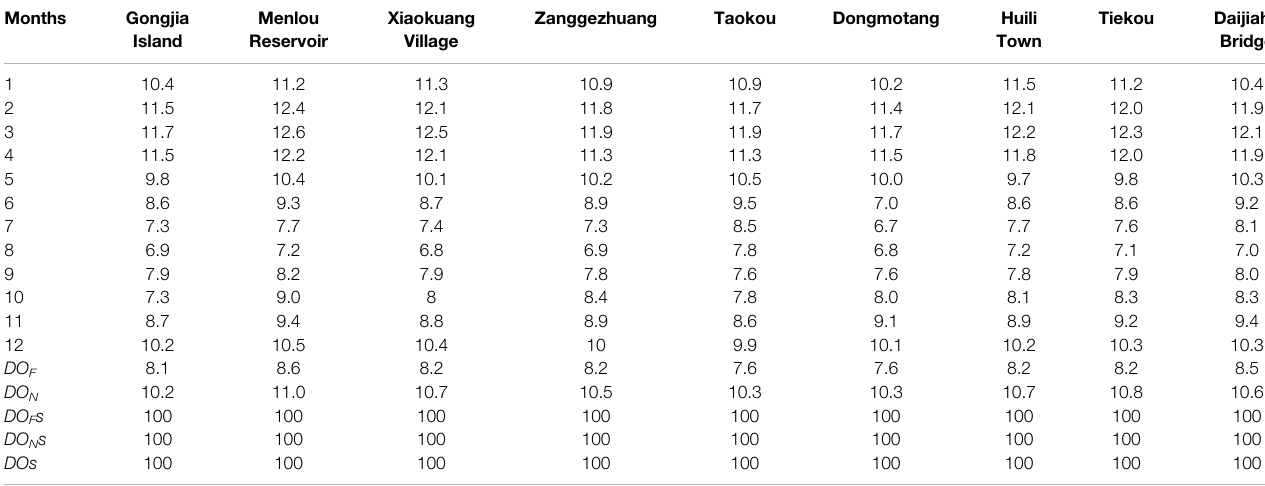
TABLE 6 | Results of DO concentration (mg/L) and grading. Months